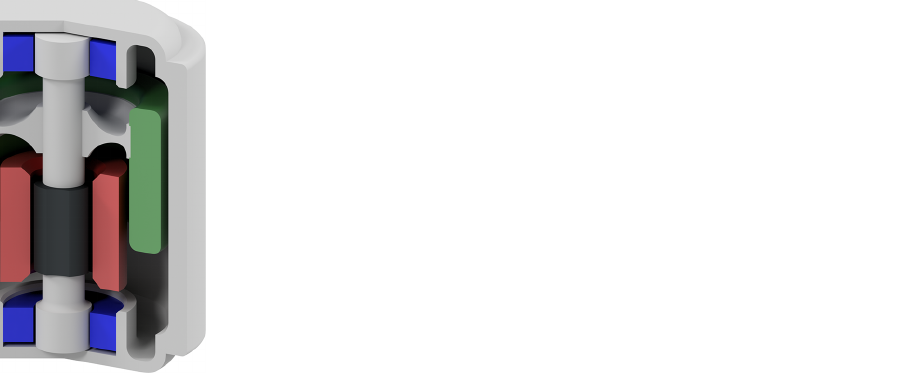
Figure 1. Schematic flywheel energy storage system (FESS) wherein red—stator; green—rotor with inertia; and blue—active magnetic bearing.